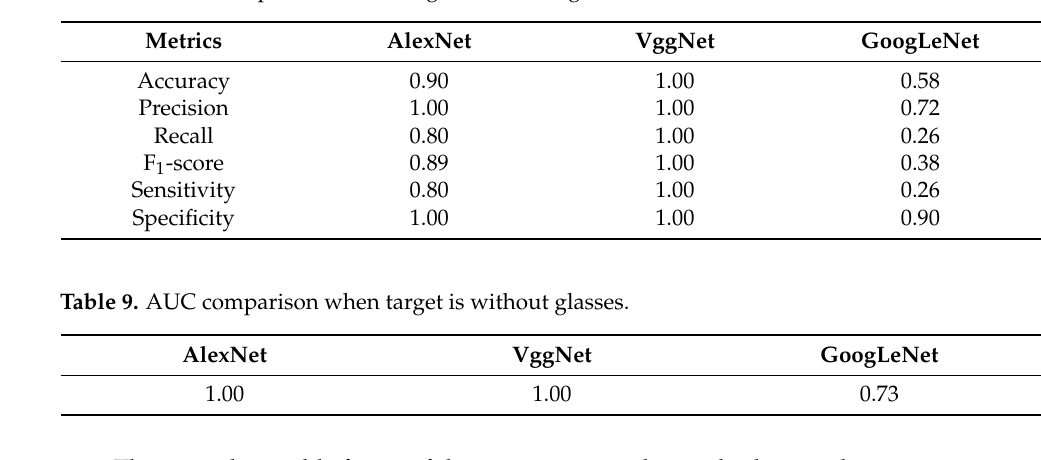
Table 8. Metric comparison when target is without glasses.